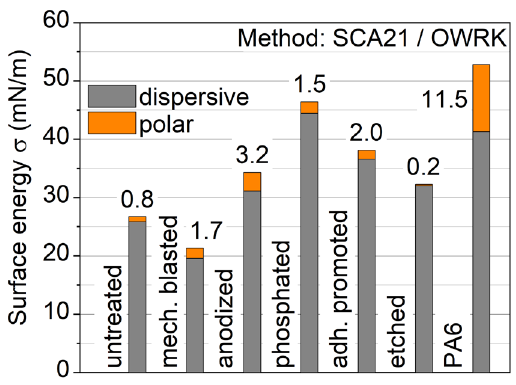
Figure 5. Surface energy of treated aluminium alloy AA6082 and PA6 foil with dispersive and polar component. Absolute value of the polar component of surface energy is highlighted through digits.